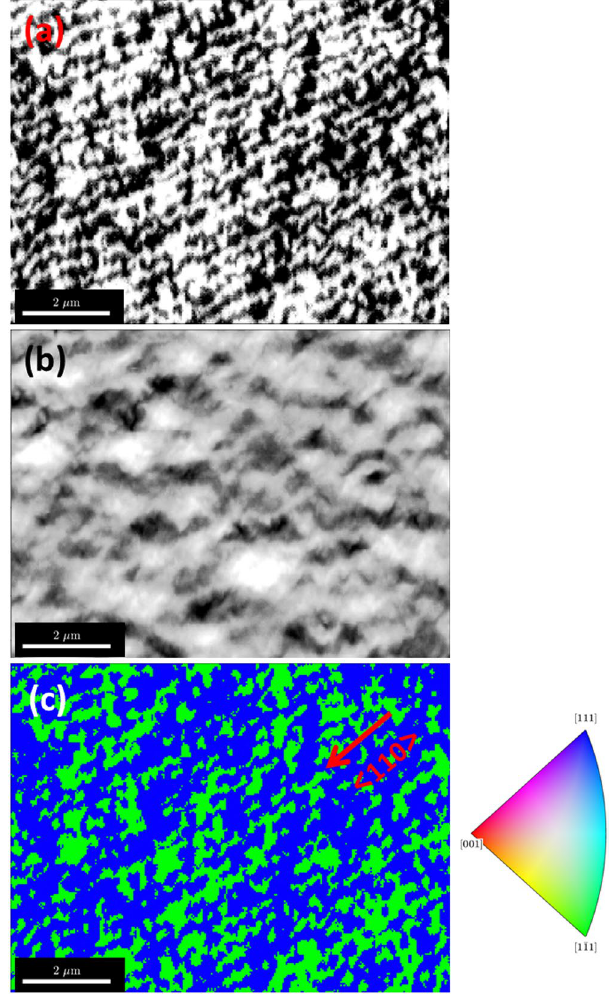
Figure 4. Imaging antiphase domains. (a ) Region of interest asymmetry imaging from the {111} bands produced from the background corrected EBSD patterns. The bright and dark regions indicate the two different pseudo-symmetric domains, (b) corresponding total intensity image of the raw EBSD patterns and ( c ) the EBSD inverse pole figure (IPF) map for the sample reference direction [1,1,1] revealing the APDs. Regions with APDs are coloured green and blue according to the IPF colour key, which indicates the expected 90° misorientation between the two possible domains. The step structures (of the order of 100 nm) can also be seen along 110